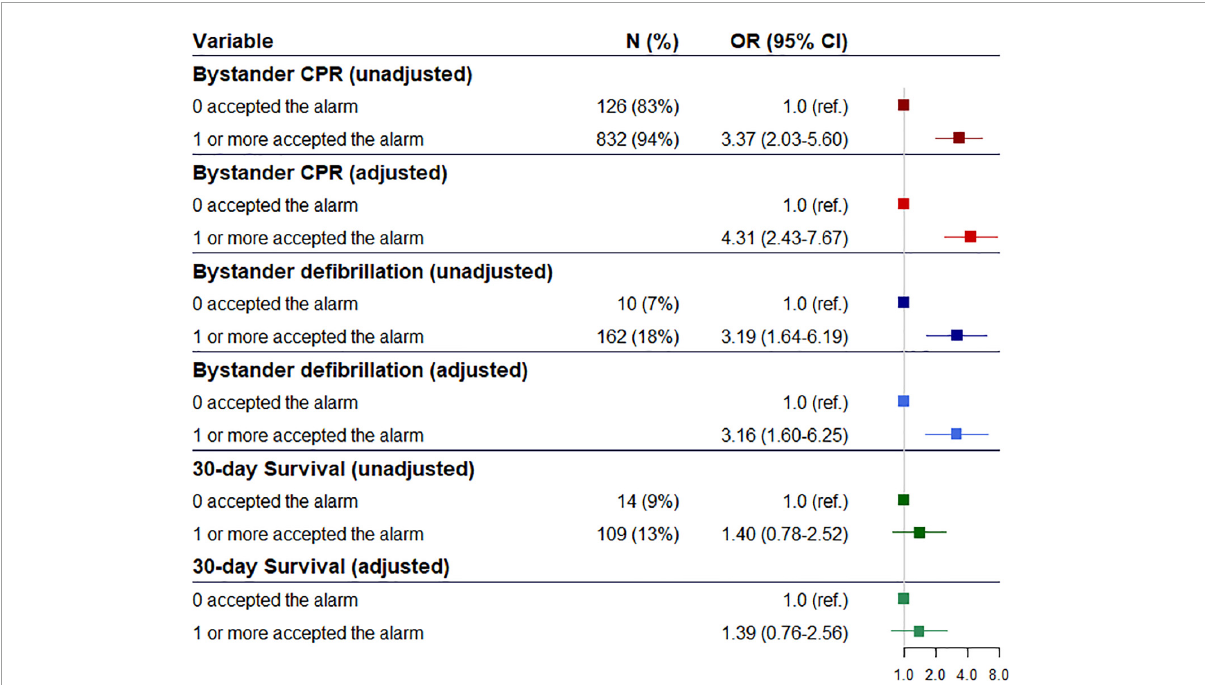
FIGURE2 Odds ratio and adjusted odds ratio of association between alarm acceptance and bystander cardiopulmonary, bystander defibrillation and 30-day survival where at least one volunteer responder accepted the alarm and arrived before the ambulance compared to cases where no volunteer responders accepted the